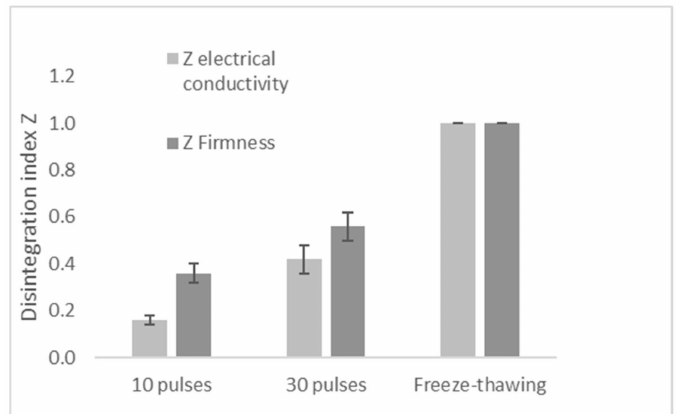
Figure 5. Disintegration index Z with electrical conductivity and Firmness